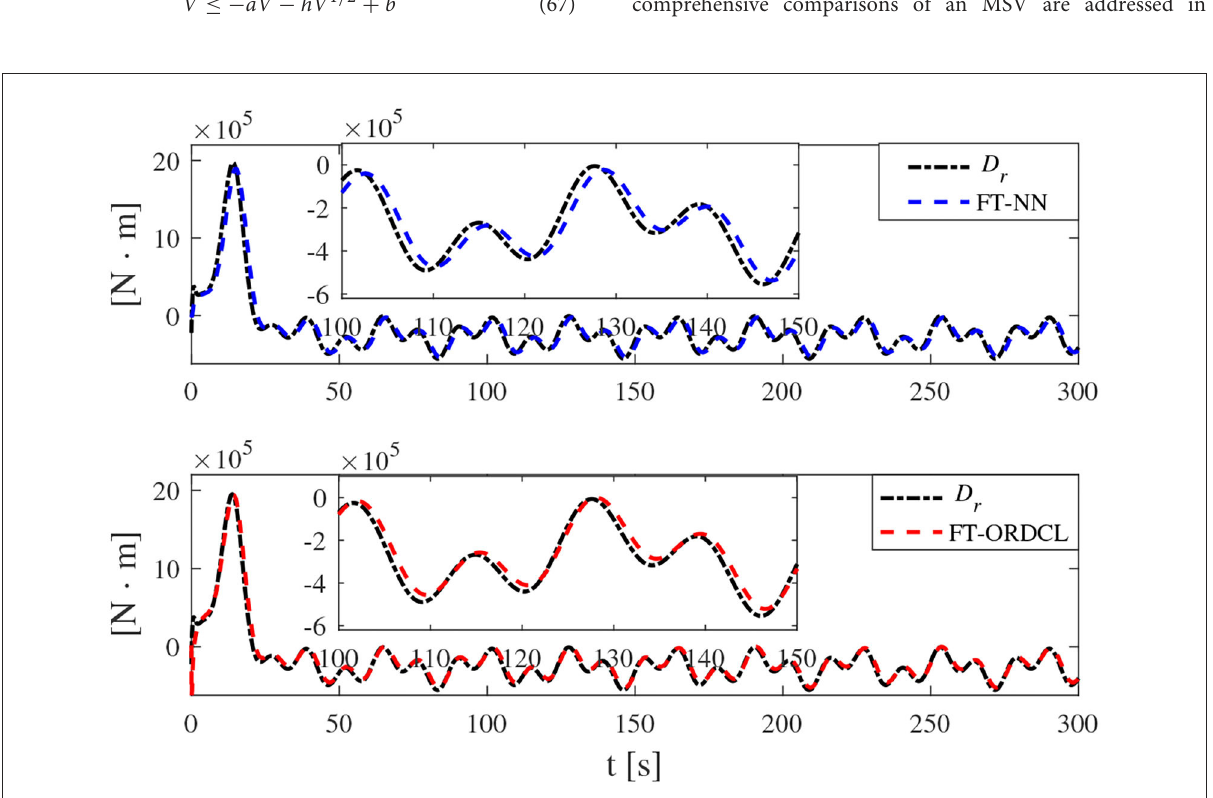
FIGURE10 D r and its estimation in Case